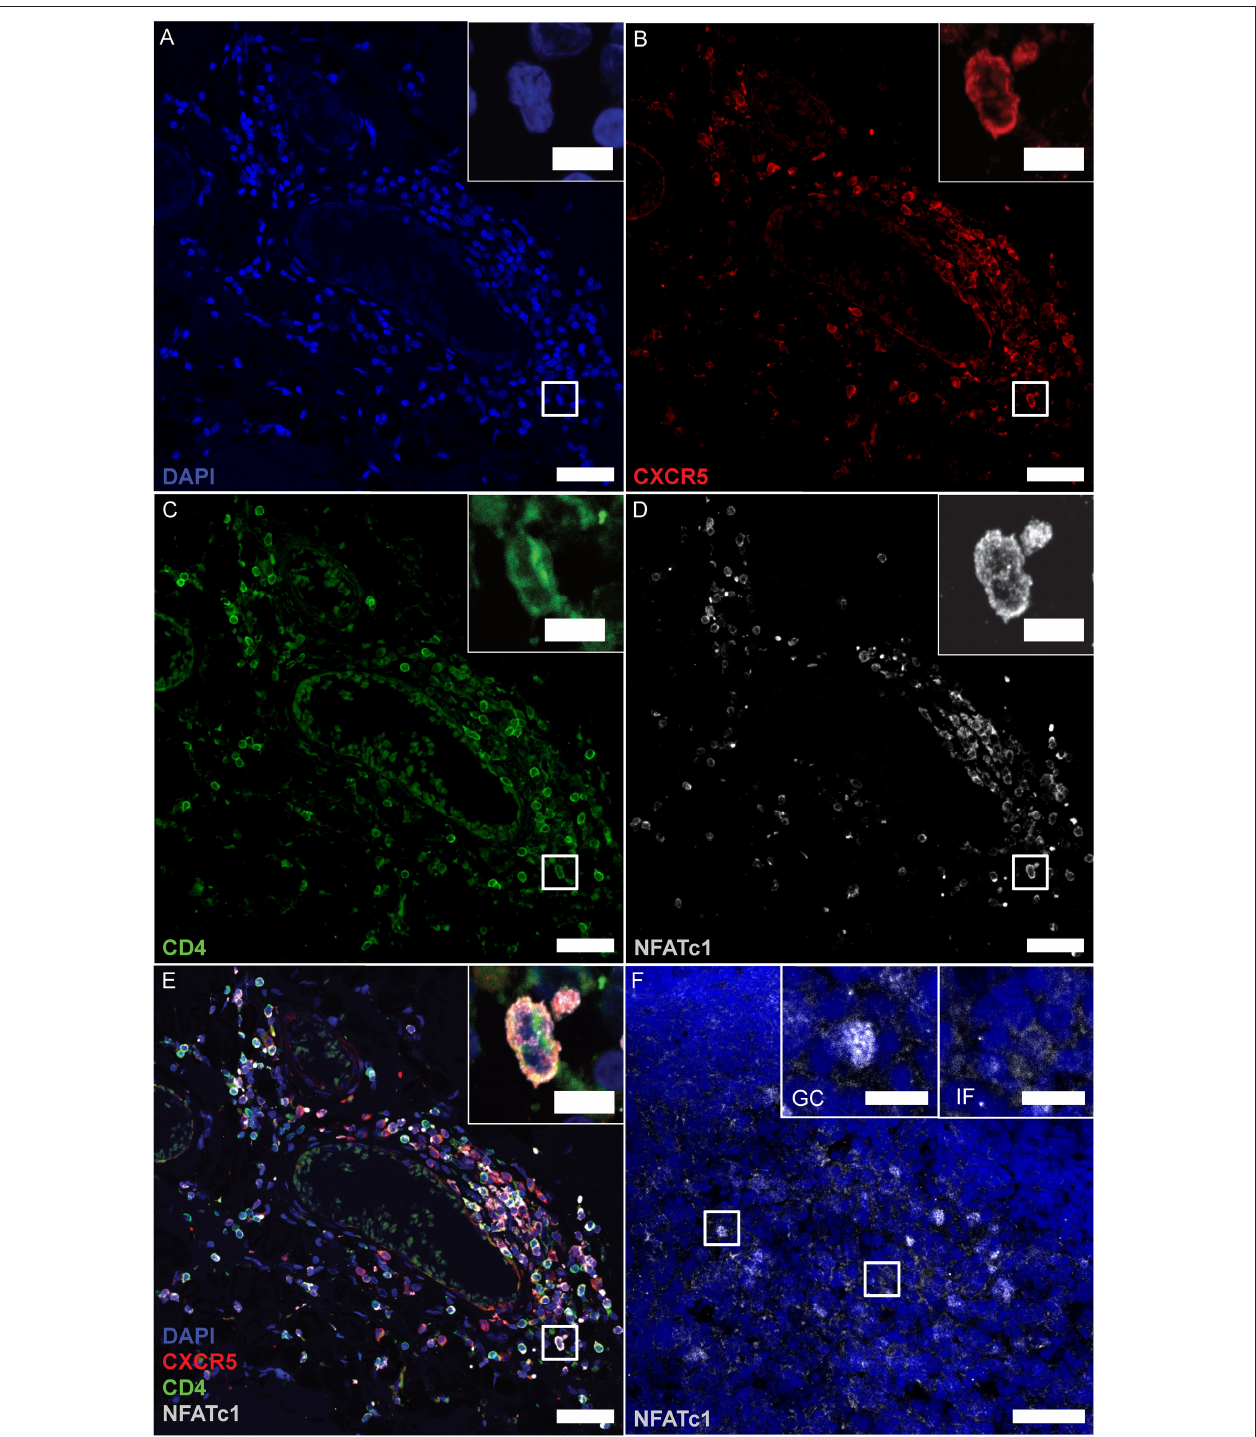
FIGURE 6 | CD4 + CXCR5 + T FH s mark positive for cytoplasmic NFATc1. (A–E) Consecutive IF staining of CD4, CXCR5 and NFATc1 on serial sections of follicle-like structures in SPMS (same region as Figures 3 , 4E–H ). Inserts show magnification of the white box. (F) NFATc1 appears to be cytoplasmic in MS brains, compared to nuclear localization within tonsillar GCs (left insert) and cytoplasmic predominance in inter-follicular cells (right insert). Scale bars indicate 100 µ m, inserts 10 µ m.